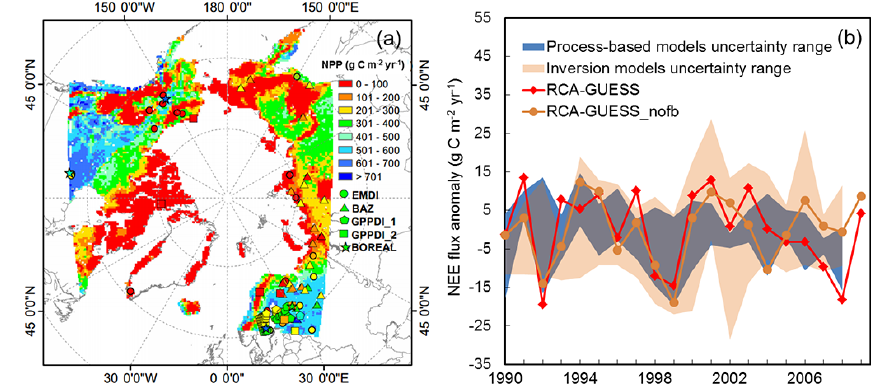
Figure 5. (a) The spatial distribution of the simulated mean NPP flux for the period 1961–1990 and the NPP flux validation data sets; EMDI (Olson et al., 2013a), BAZ (Denissenko et al., 2013), GPPDI_1 (Olson et al., 2013b), GPPDI_2 (Zheng et al., 2013), BOREAL (Gower et al., 2012). (b) The inter-annual variation of Arctic tundra NEE anomalies from the RCA-GUESS feedback and non-feedback runs, the uncertainty ranges of process-based models (LPJ-GUESS WHyMe, TEM6, TCF, Orchidee) and inversion models for the period